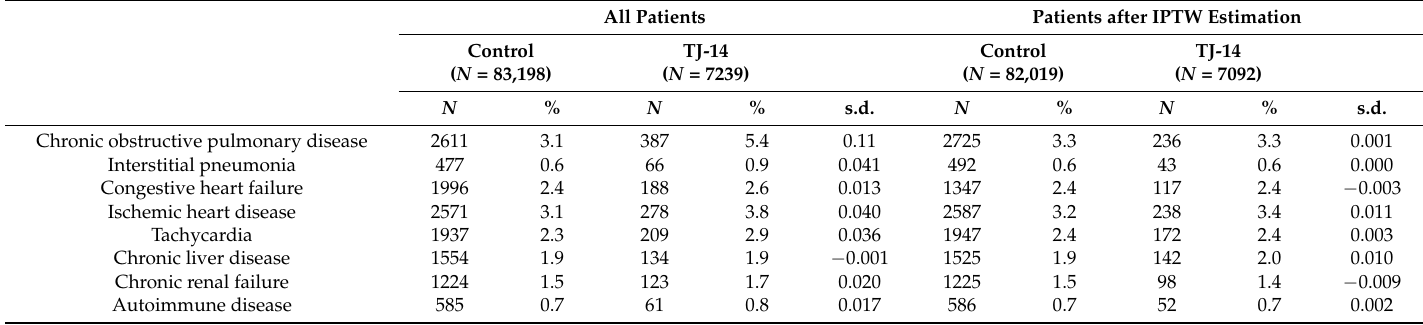
Table 2. Comorbidities on first admission for CPT-11 chemotherapy with or without TJ-14, before and after stabilized inverse probability treatment weighting using propensity scores.